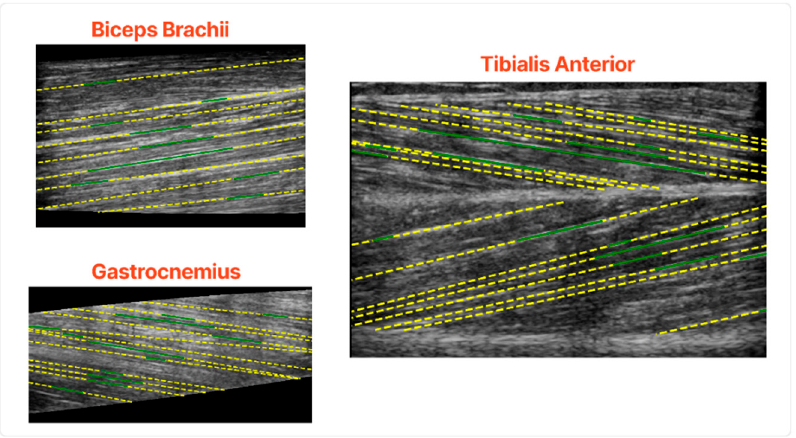
Figure 8. Qualitative results of the fascicles extraction in the validation set. The green lines are the algorithm’s output before the fascicles extended in the whole muscle and the yellow lines after.